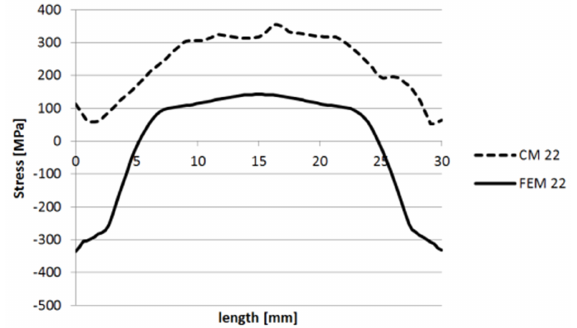
Figure 55. Stress levels in 22 direction along the AB line segment.